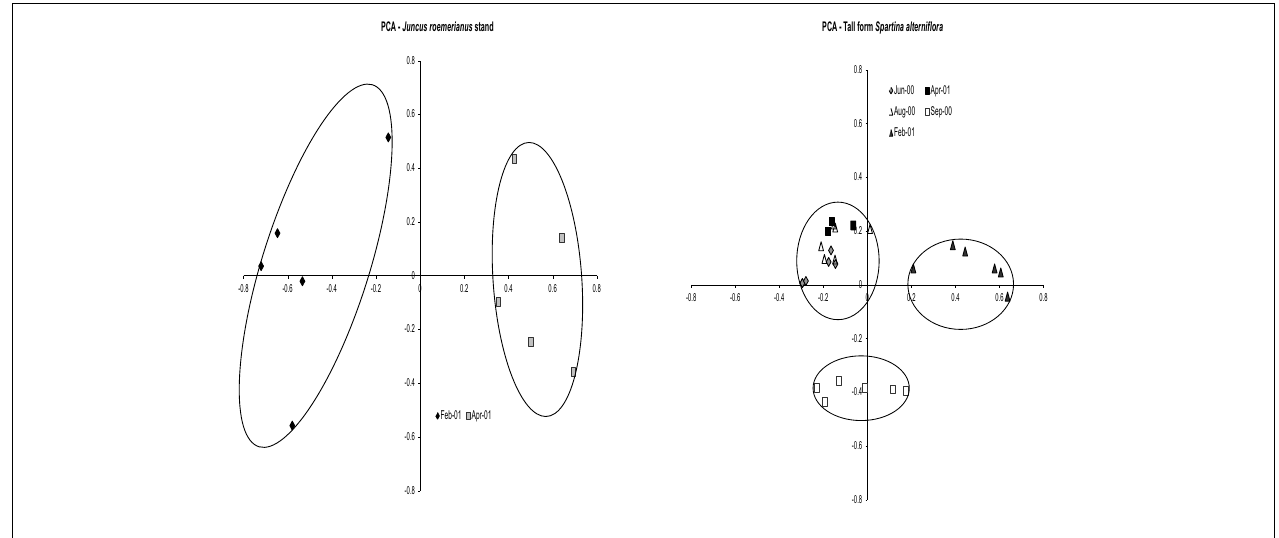
represents 20.8% of the variance. For tall form S. alterniflora Axis 1 represents 25.8% of the variance and Axis 2 represents 15.5% of the variance. Reproduced with kind permission from Davis et al. (2011), Supplementary Figure 1A.